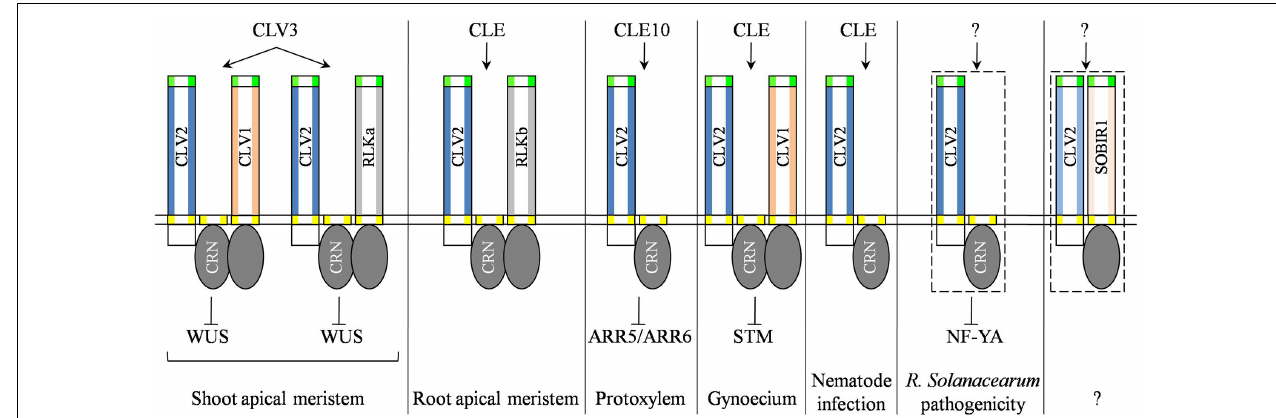
FIGURE 1 | Schematic representation of different CLV2-associated receptor complexes that mediate CLE signaling in multiple biological processes. Particularly, the genetic and biochemical evidence are unknown for the physical interaction between CLV2 and CRN, both of which are potentially involved in R. solanacearum pathogenicity, and CLV2 associates with SOBIR1 that controls a yet uncharacterized physiological process (dash-line boxed). RLKa and RLKb represent unknown receptors that function together with CLV2 and CRN/SOL2 to form multimers and perceive CLE signals.